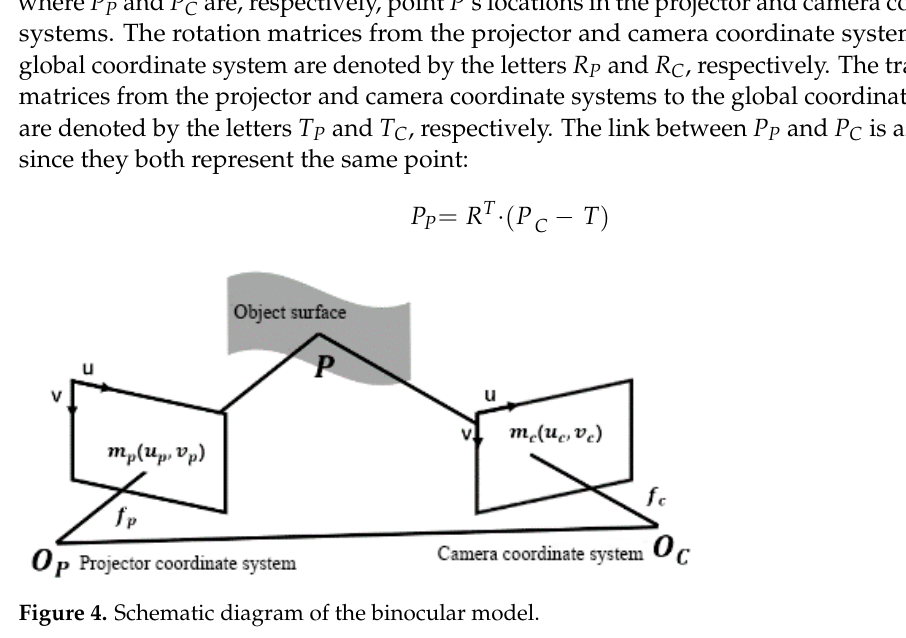
Figure 4. Schematic diagram of the binocular model.